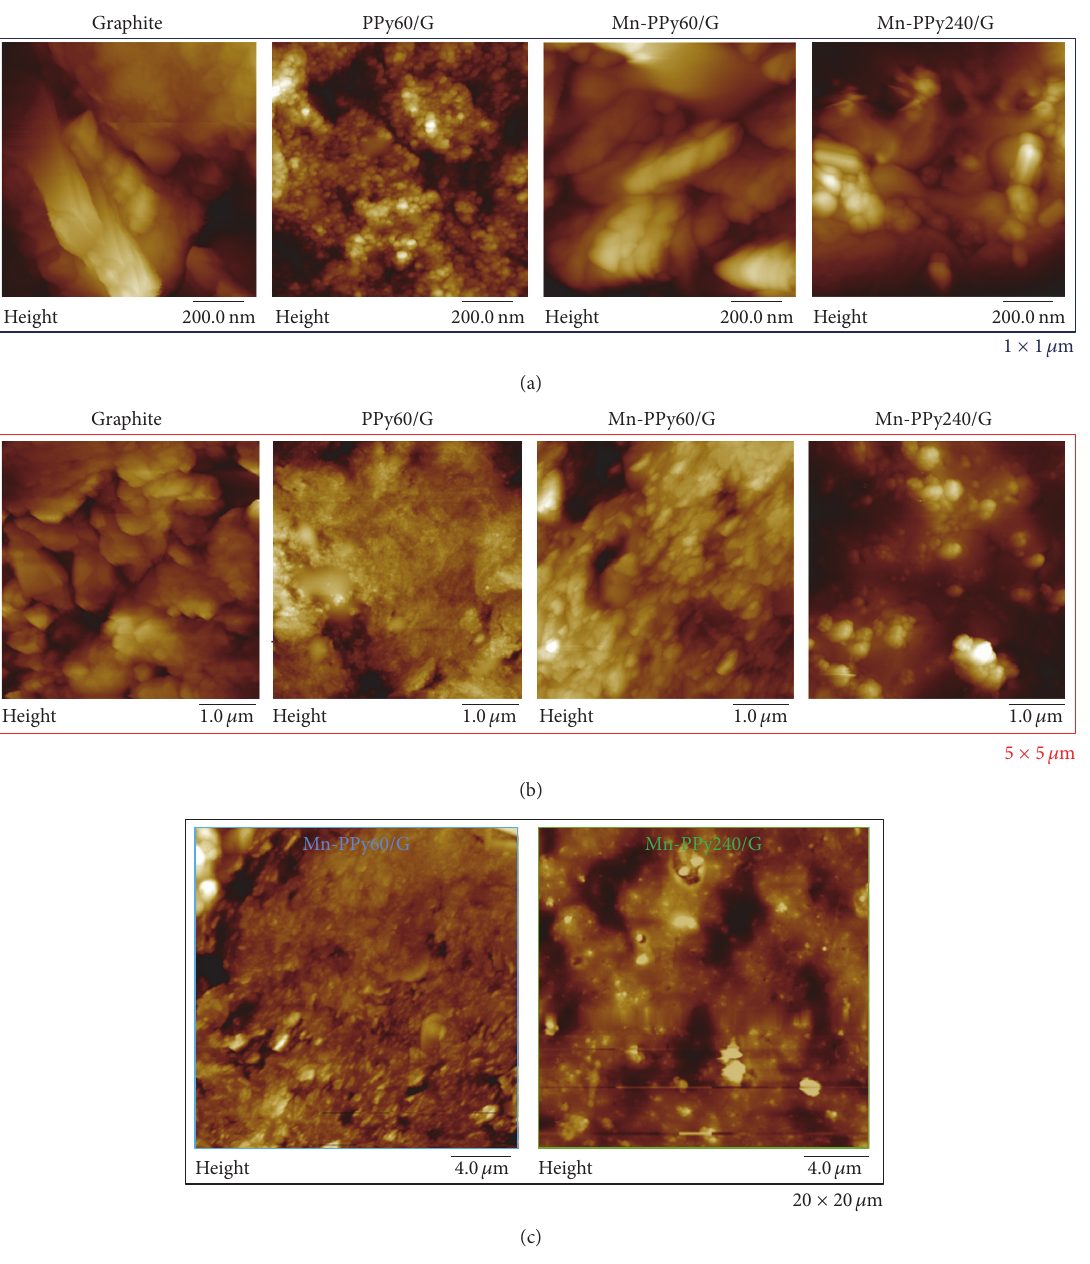
Figure 5: AFM height images of the graphite (G) substrate as well as of the following: PPy60/G, Mn-PPy60/G, and Mn-PPy240/G electrodeposits. Table 2: AFM surface morphology indicators of graphite, PPy, and Mn/PPy